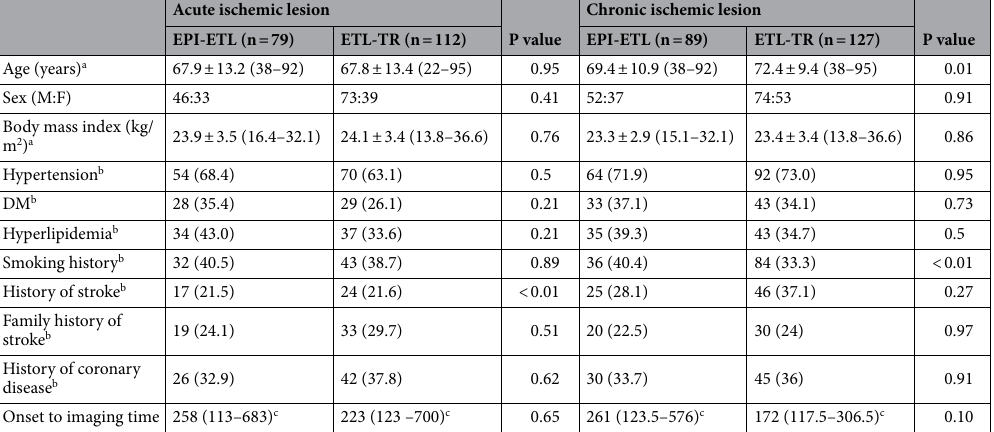
Table 2. Demographics of the patients. a Numbers indicate mean ± standard deviation and the parentheses indicate the range. b Parentheses indicate the range. c Median (nterquartile